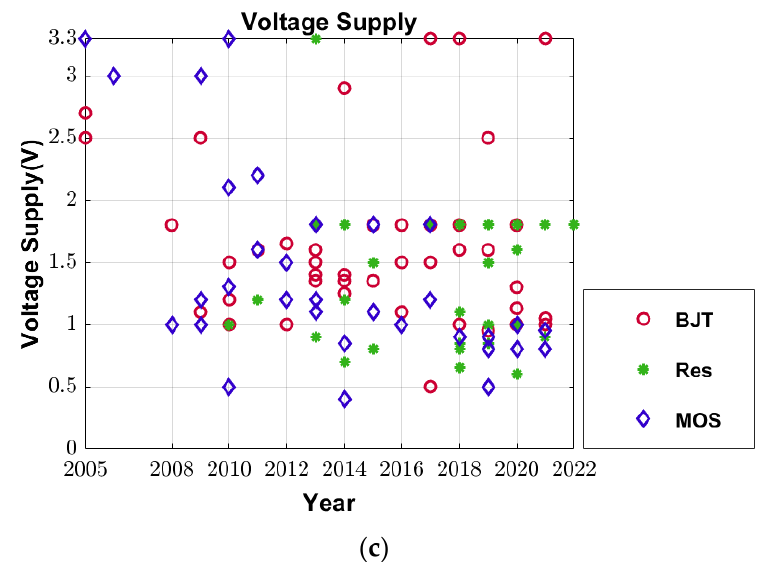
Figure 1. Comparison of ( a ) area, ( b ) resolution figures of merit (RFOM) and ( c ) voltage supply level for three types of temperature sensors: the BJT, the resistor and the MOS-based ones. The RFOM is calculated as the energy/conversion · resolution 2 and is a measure of energy efficiency in reference to its resolution.